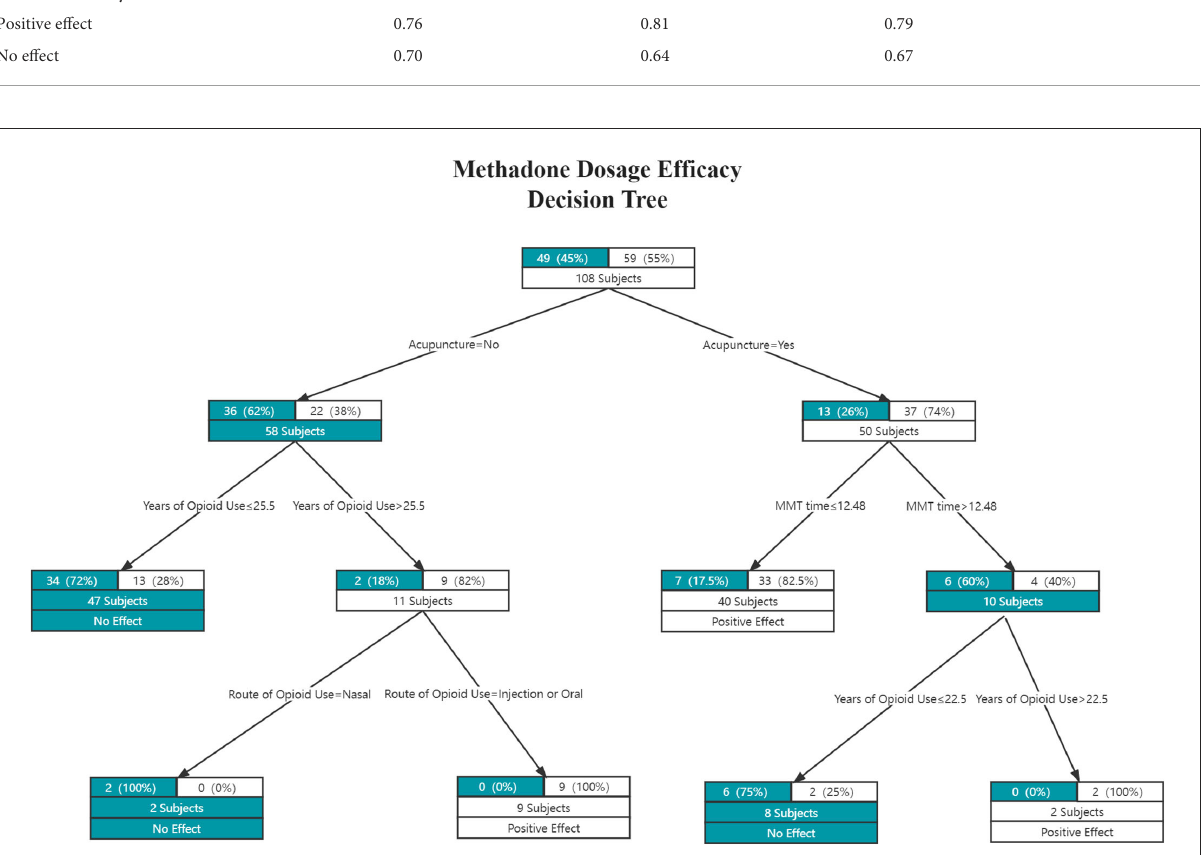
FIGURE2 The methadone dosage efficacy decision tree. Each edge represents a classification attribute, and each node contains the number of samples from the previous node up to that point, and their distribution among the two classes. Each leaf node is also labeled with the classification choice (White = positive effect; Gree n = no